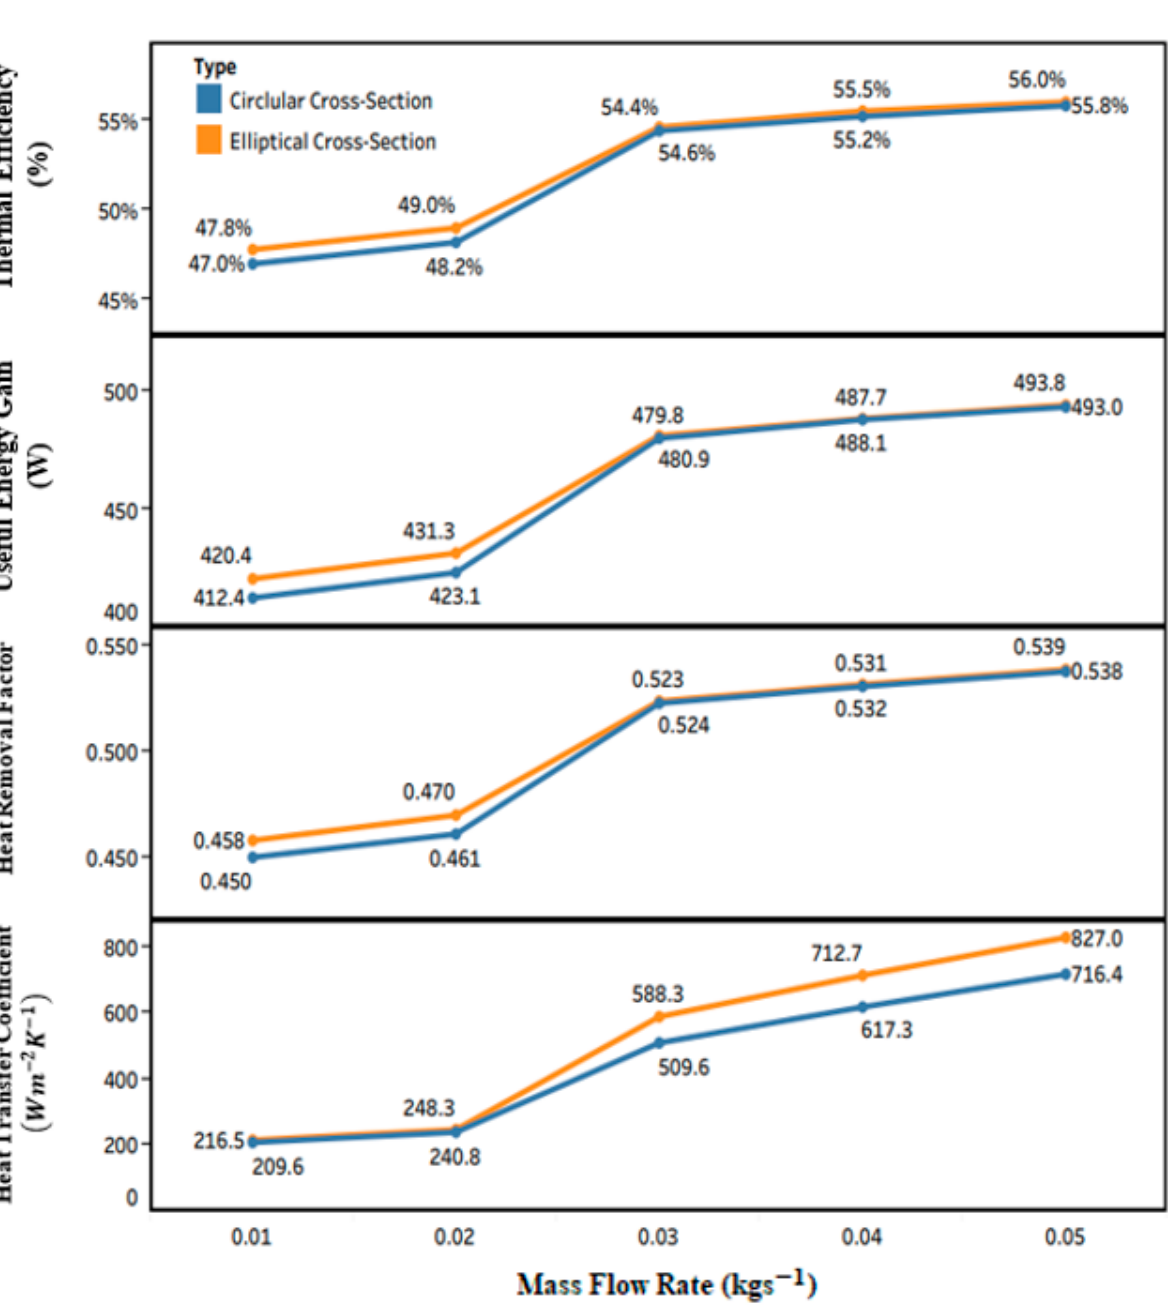
Figure 8. Effects of 𝑚(cid:4662) on ℎ (cid:3033)(cid:3036) , 𝐹 (cid:3019) , 𝑄 (cid:3048) , and 𝜇 (cid:3021)(cid:3035) .